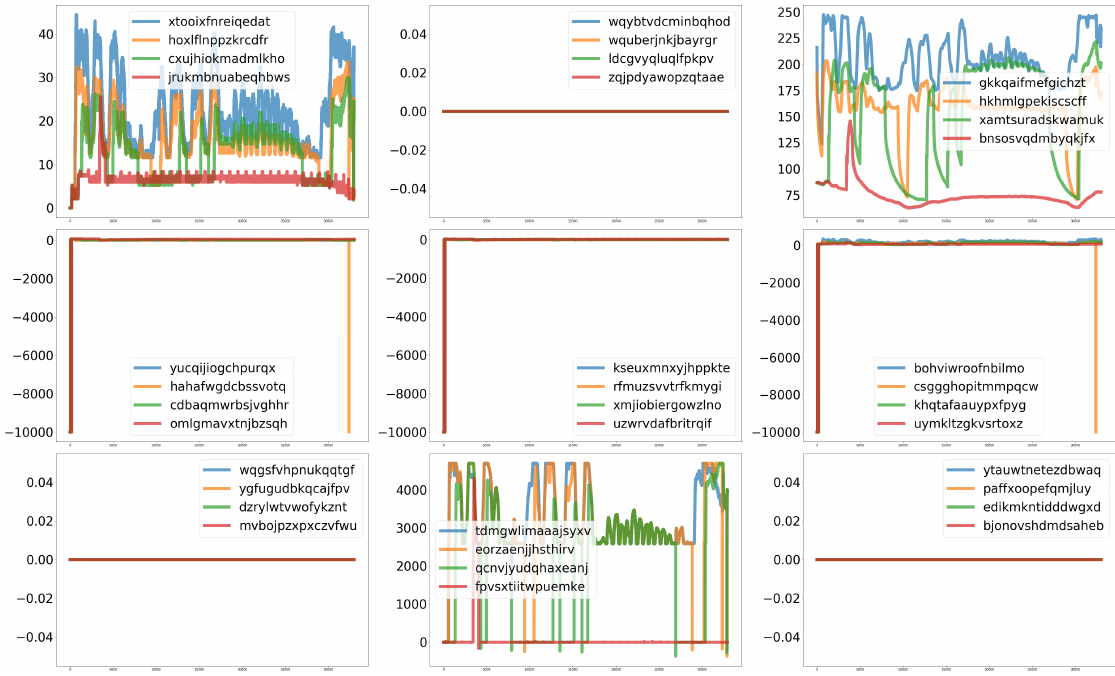
Figure 1. Anonymous sensor data during a flight for the four healthy cooling units installed in an